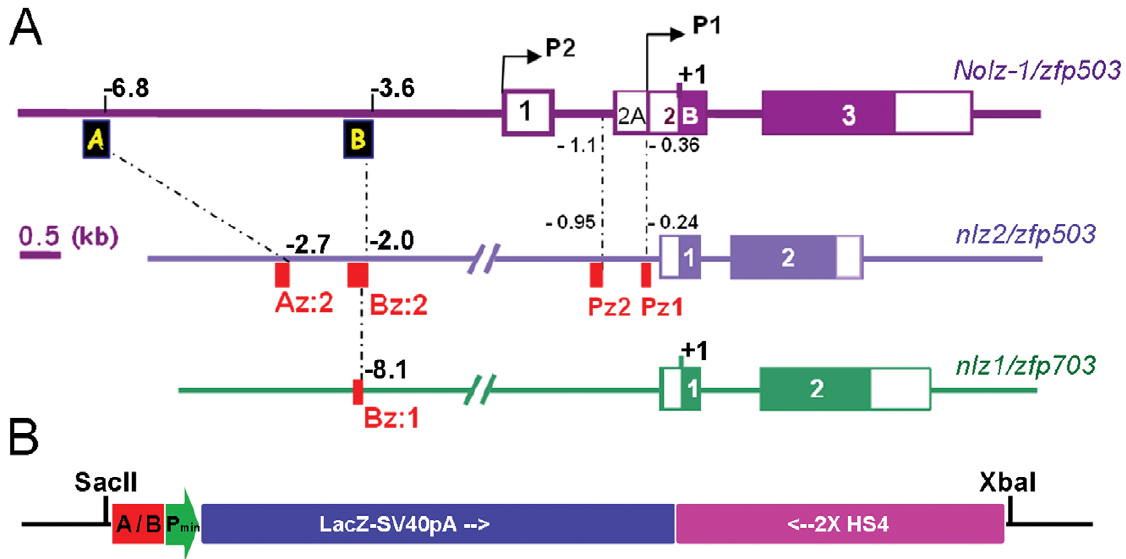
Figure 1. Evolutionarily conserved up-stream cis -elements of mouse Nolz-1/Zfp503 gene and the UREA-LacZ and UREB-LacZ transgenic constructs. A: Diagrams show the locations of the UREA (A) and UREB (B) (black boxes) conserved upstream cis -elements of mouse Nolz-1/zfp503 and their relative conserved regions in zebrafish nlz2/zfp503 (red boxes, Az:2, Bz:2) and nlz1/zfp703 loci (red box, Bz:1). Pz1 and Pz2 (red boxes) are another two zebrafish/mouse conserved cis -elements identified in the potential promoter region of nlz2/zfp503 . Numbers indicate the distances (in kb) relative to the translation start condon ( + 1). B: The UREA-LacZ and UREB-LacZ transgenic constructs. The UREA or UREB (A/B) elements were inserted upstream to a minimal promoter (Pmin) following by LacZ expression cassette (LacZ-SV40pA) and two direct repeats of insulators (2XHS4). The SacII and XbaI sites were used to release the transgenic fragments from the vector.